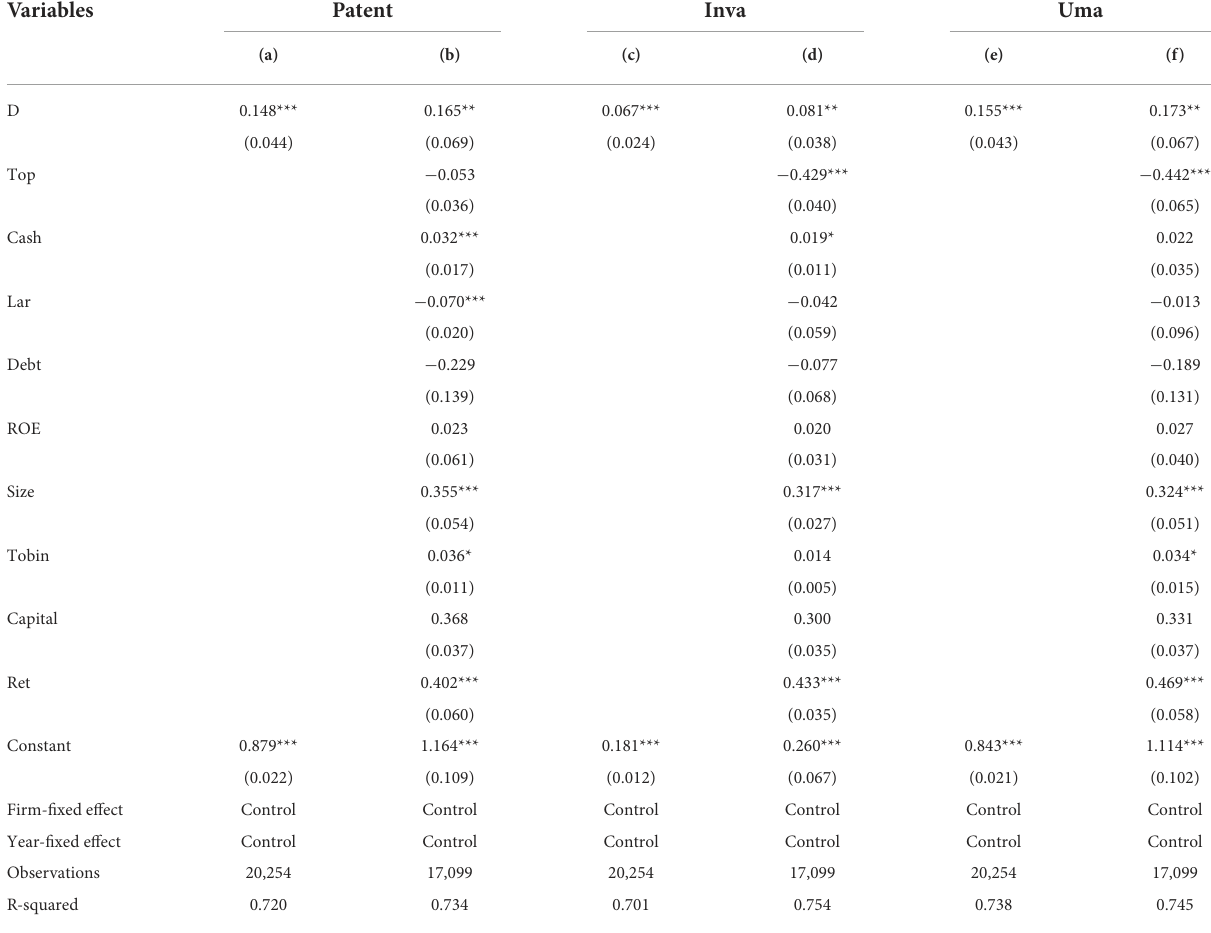
TABLE 3 Results of benchmark